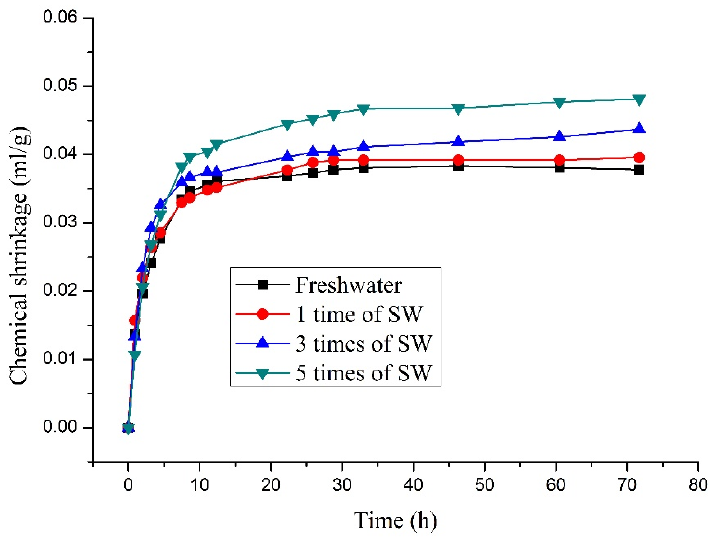
Figure 7. Influence of the seawater concentration on the chemical shrinkage of CSA cement.